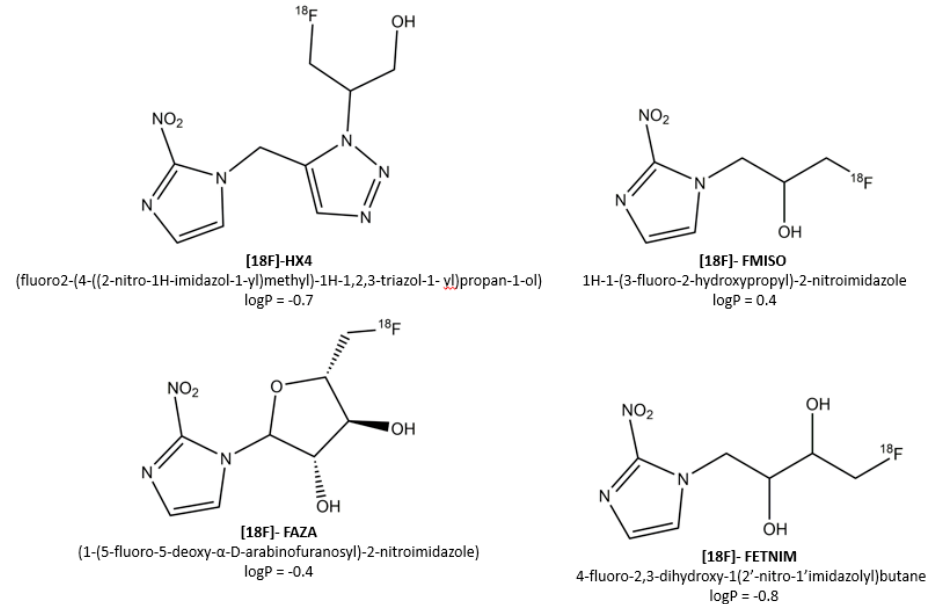
Figure 1. The currently most ‐ investigated 2 ‐ nitroimidazole PET tracers and their associated logP